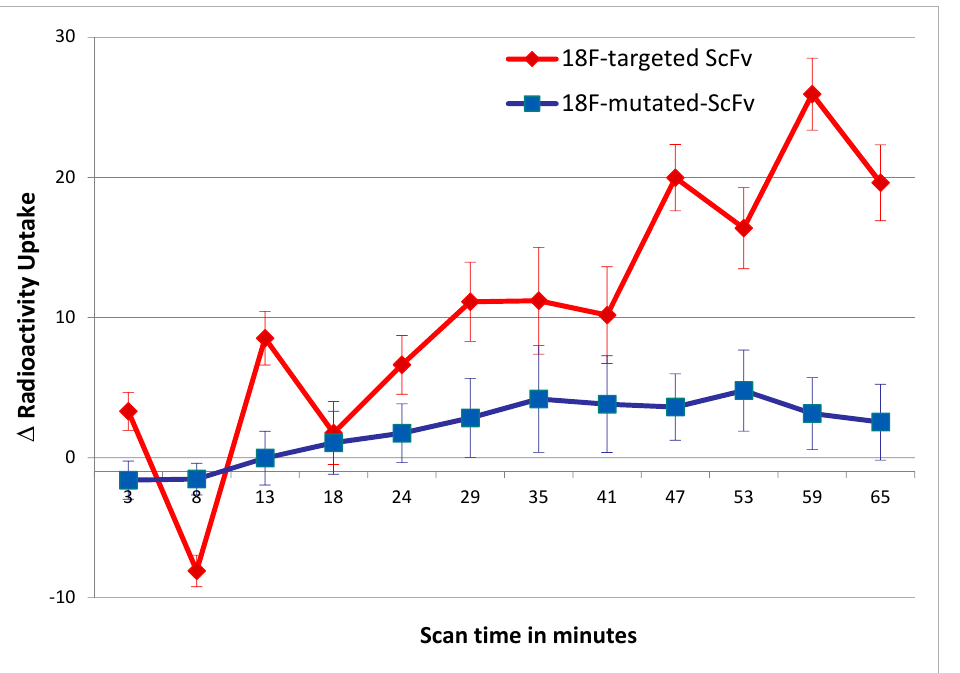
Figure 5. Results from image analysis of ROIs. The difference in radioactivity uptake between the injured vessel and intact vessel is plotted against scan time. The red line represents the difference in vessel uptake in mice injected with 18 F-targeted-ScFv, whilst the blue line represents the difference in vessel uptake in mice injected with 18 F-mutated-ScFv. For mice injected with [ 18 F]FBEM-labelled targeted-ScFv, the difference in radioactive uptake, between injured and non-injured, is only observed at later time points after 45 min into scan time (n = 5). Means were compared by use of a 1-way ANOVA.